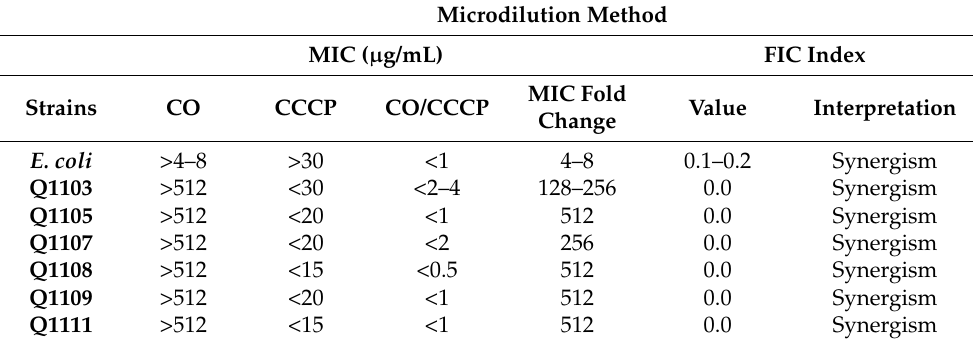
Table 1. Antibiotic susceptibility of B. intermedia strains to CO with and without CCCP by the microdilution method and FIC index